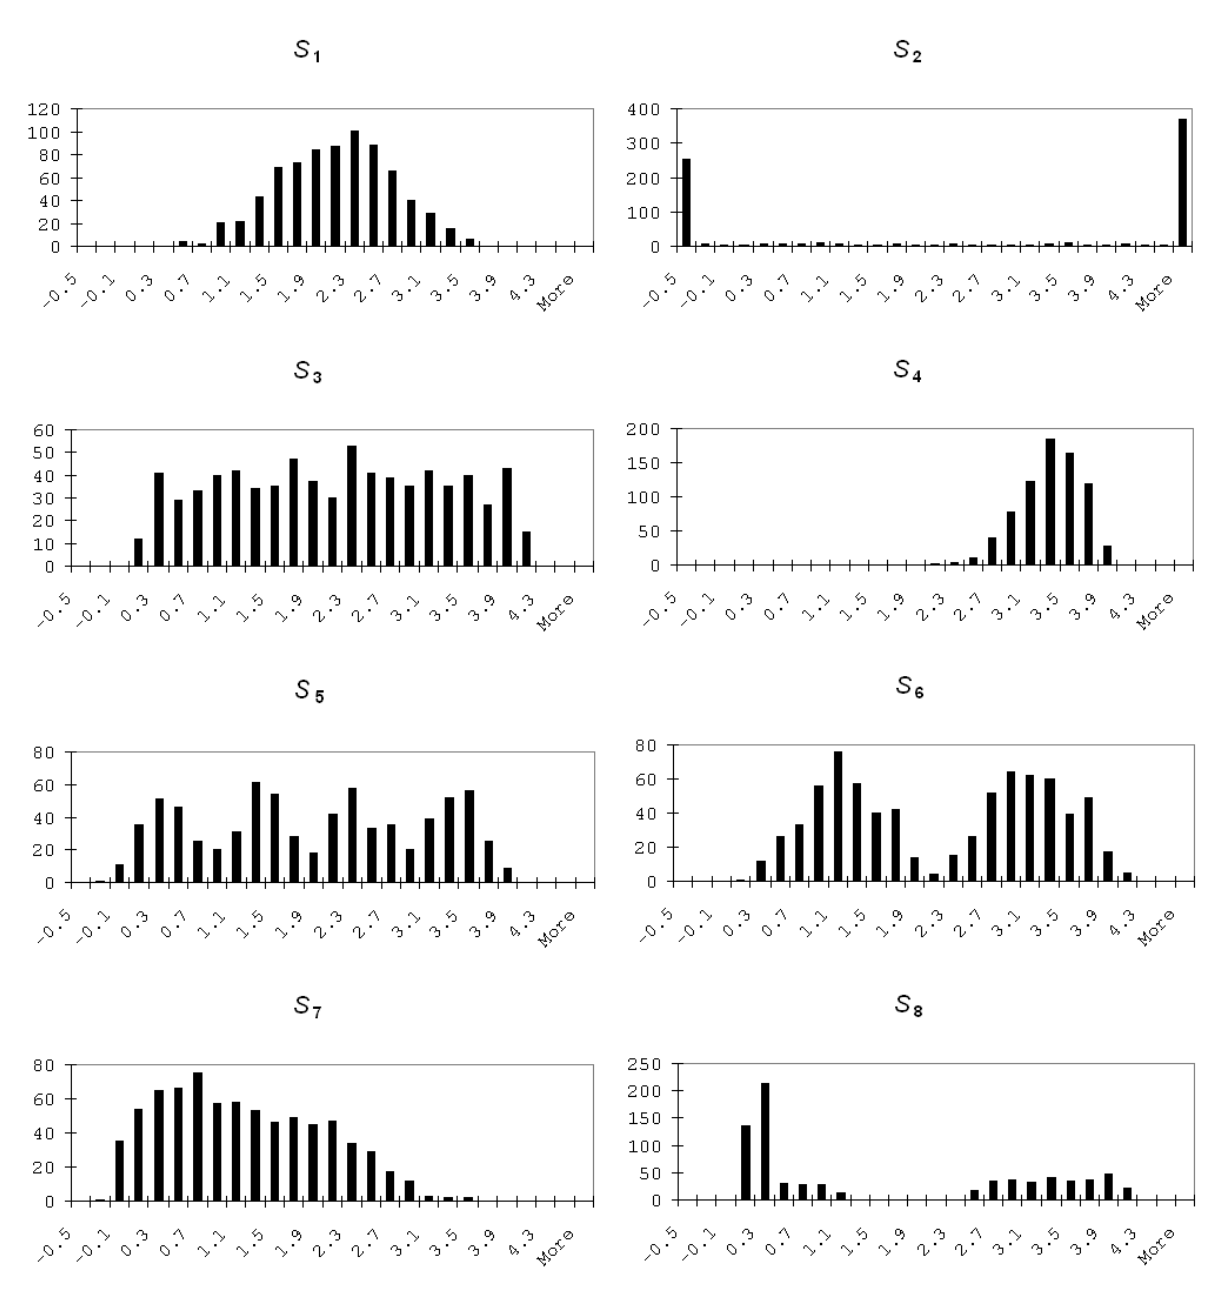
Figure 2: Histograms of dependant variables for artificial datasets used for experimental